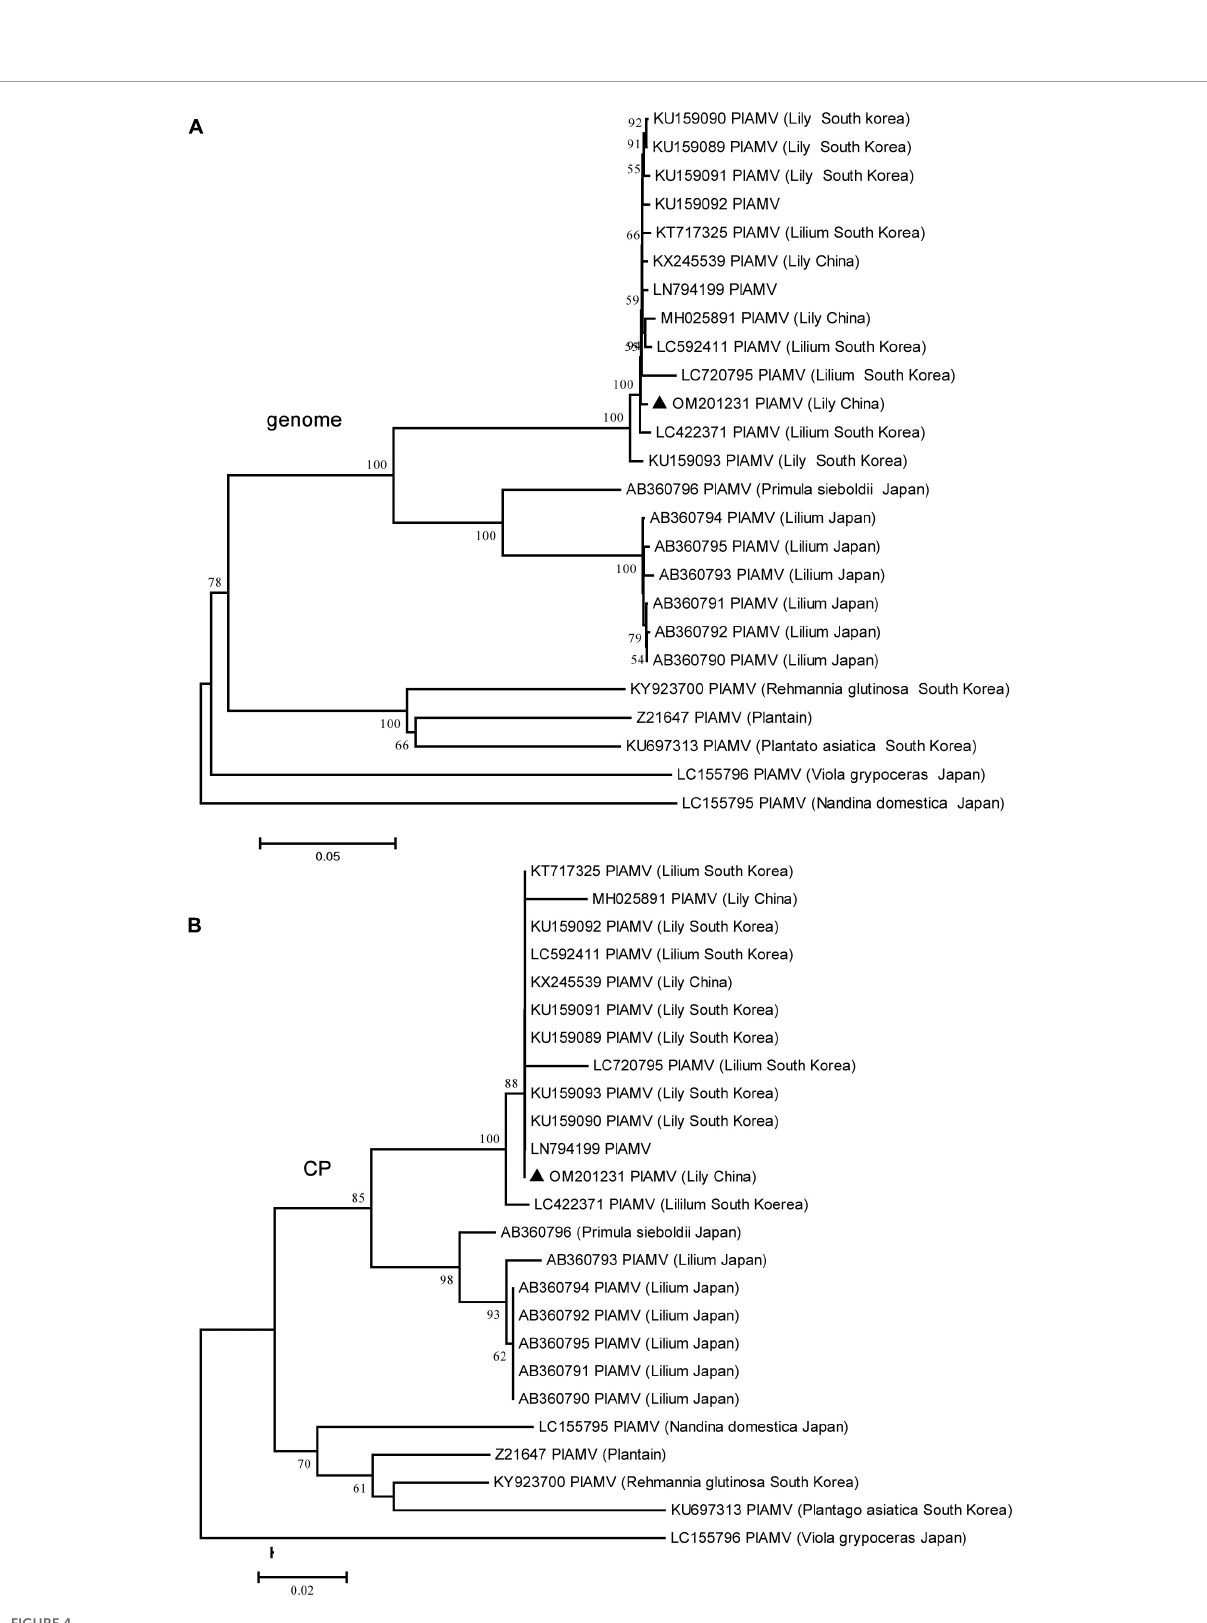
FIGURE4 Phylogenetic analyses of plantago asiatica mosaic virus (PlAMV) using the NJ method with 1,000 bootstrap replicates. All available complete genome sequences of PlAMV were collected. (A) Based on the complete genome sequences. (B) Based on the coat protein (CP) amino acid sequences. Bootstrap values are given by numbers at the relevant nodes in the topology and only bootstrap values of ≥ 50% were shown. PlAMV BJ strain (OM201231) was indicated with solid blue